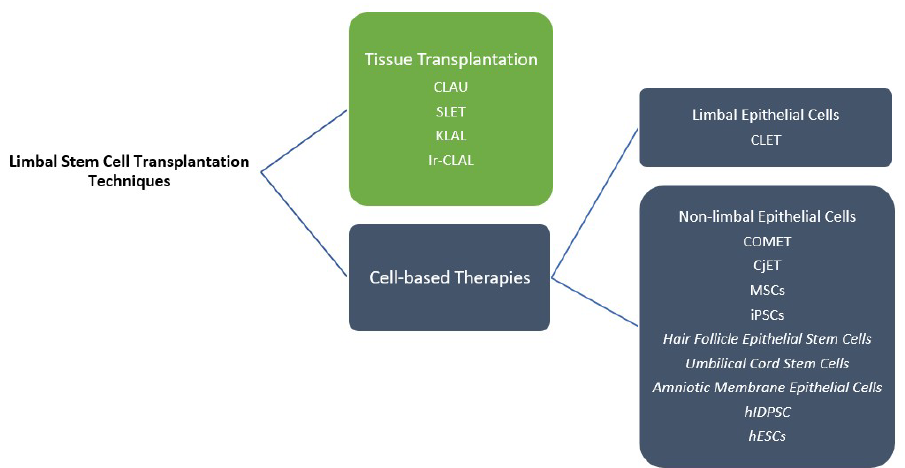
Figure 2. Different methods of limbal stem cell transplantation (CLAU: conjunctival limbal autograft, CLET: cultivated limbal epithelial transplantation, SLET: simple limbal epithelial transplantation, KLAL: kerato-limbal allograft, Ir-CLAL: living-related conjunctival limbal allograft, COMET: cultivated oral mucosal epithelial transplantation, CjET: conjunctival epithelial transplantation, MSCs: mesenchymal stem cells, iPSCs: induced pluripotent stem cells, hIDPSC: human immature dental pulp stem cells, hESCs: human embryonic stem cells). Currently, only animal studies are available for methods written in italic format in the non-limbal epithelial cells box